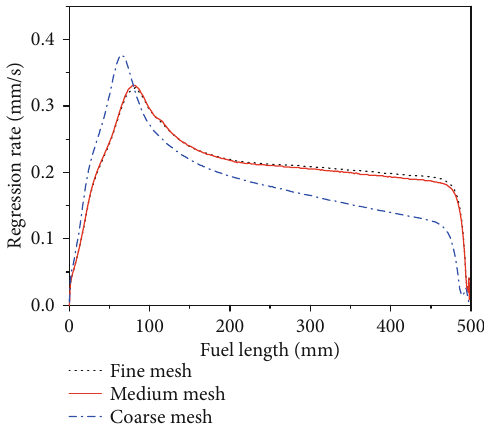
Figure 3: The regression rate of the validation